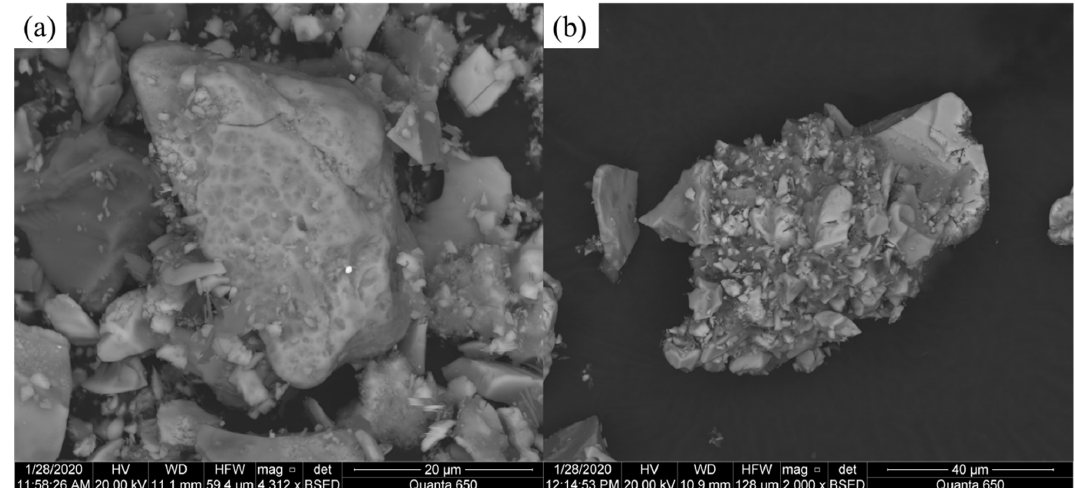
Figure 14. Scanning electron micrographs of the ultrasound-assisted chalcopyrite-leached residue at ( a ) 50 °C and ( b ) 80 °C (leaching conditions: ultrasound power amplitude 20%, 1% S/L, 0.5 M sulfuric acid concentration, and 800 rpm stirring speed).